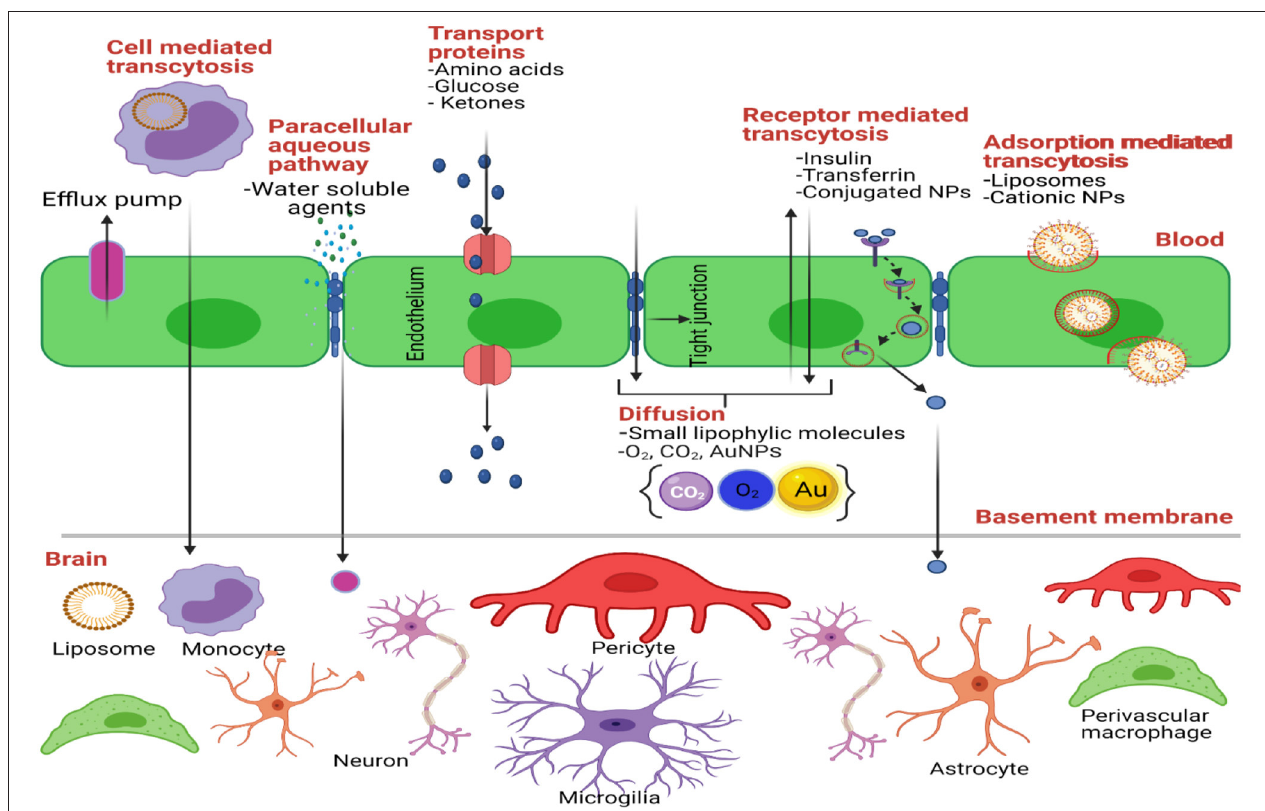
FIGURE 2 | Transport mechanisms through the BBB. Created with BioRender (https://Biorender.com/).